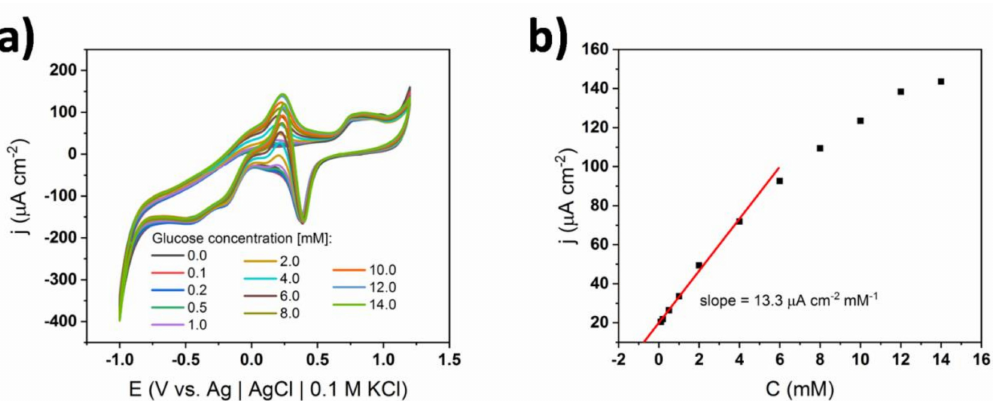
Figure 13. ( a ) Cyclic voltammograms of TiND | AuNP Nafion-coated electrode registered for di ff erent glucose concentrations in 0.1 M sPBS, ( b ) calibration curve based on glucose oxidation peak at + 0.35 V.